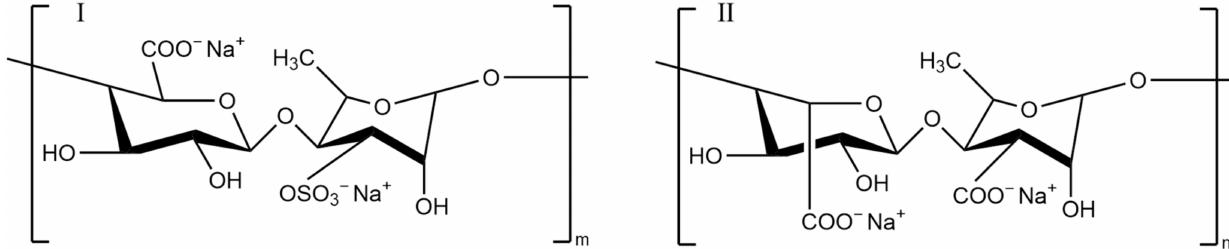
Figure 11. Chemical structure of ulvan fragments (( I ) β -D-glucuronic acid (1->4) type; ( II ) α -D-glucuronic acid (1->4)